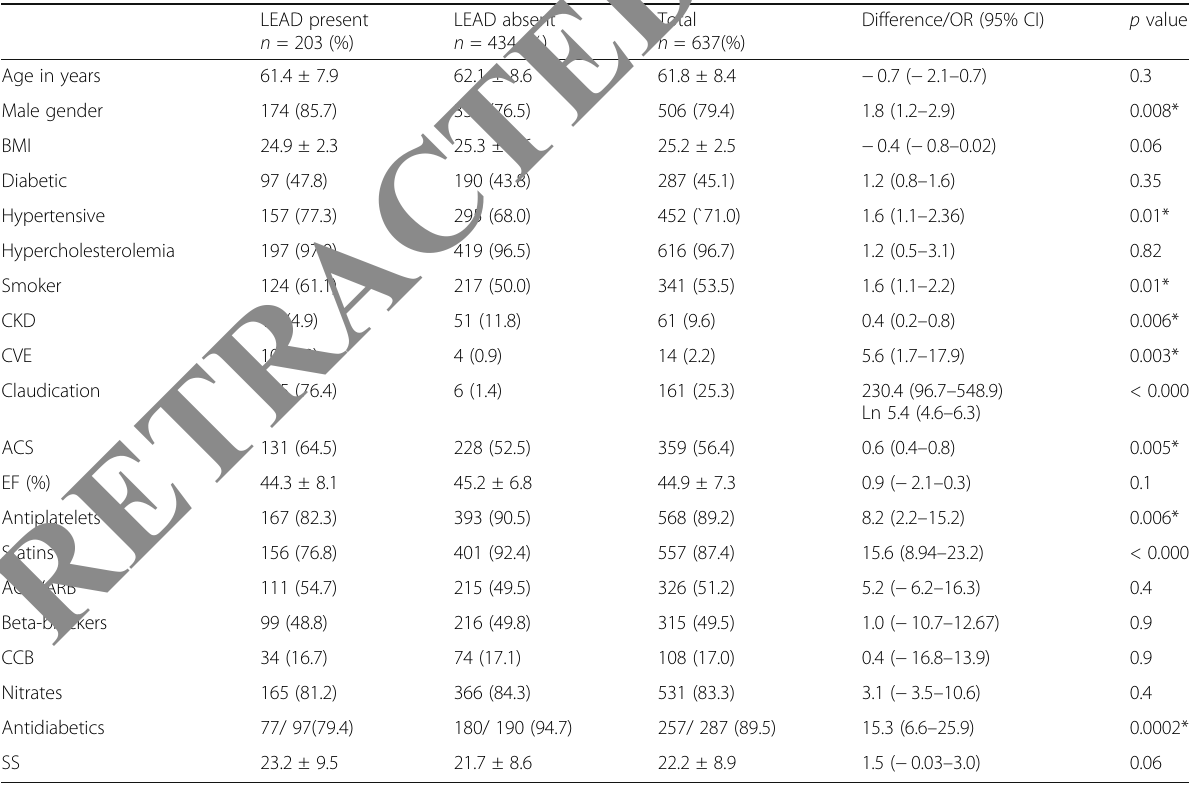
Table 1 Patients ’ baseline characteristics and comparison of characteristics among subjects with and without LEAD